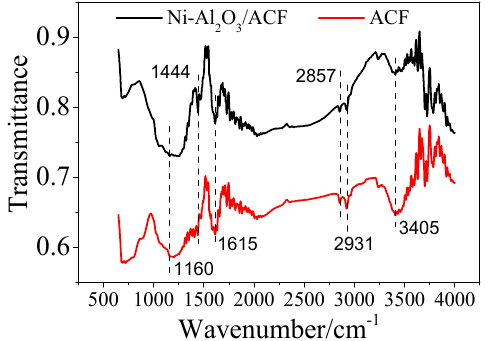
Figure 4. Fourier transform infrared spectroscopy (FTIR) spectra of ACF and catalyst of Ni–Al 2 O 3 /ACF.